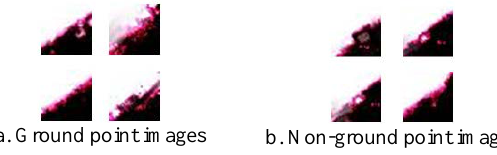
Figure 2. Feature images converted in a steep